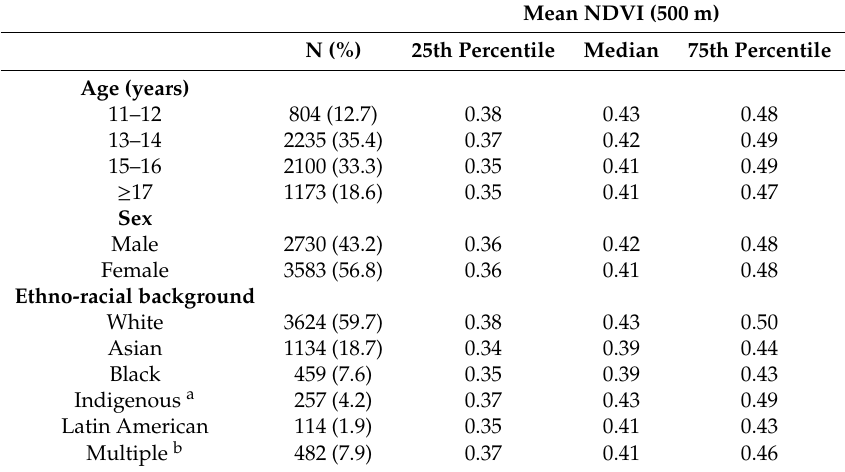
Table 1. Sample characteristics of middle- and high-school students in Ontario who participated in the 2016 OSDUHS ( N = 6313) and distribution of mean greenness (NDVI) at 500 m from 2016 CANUE